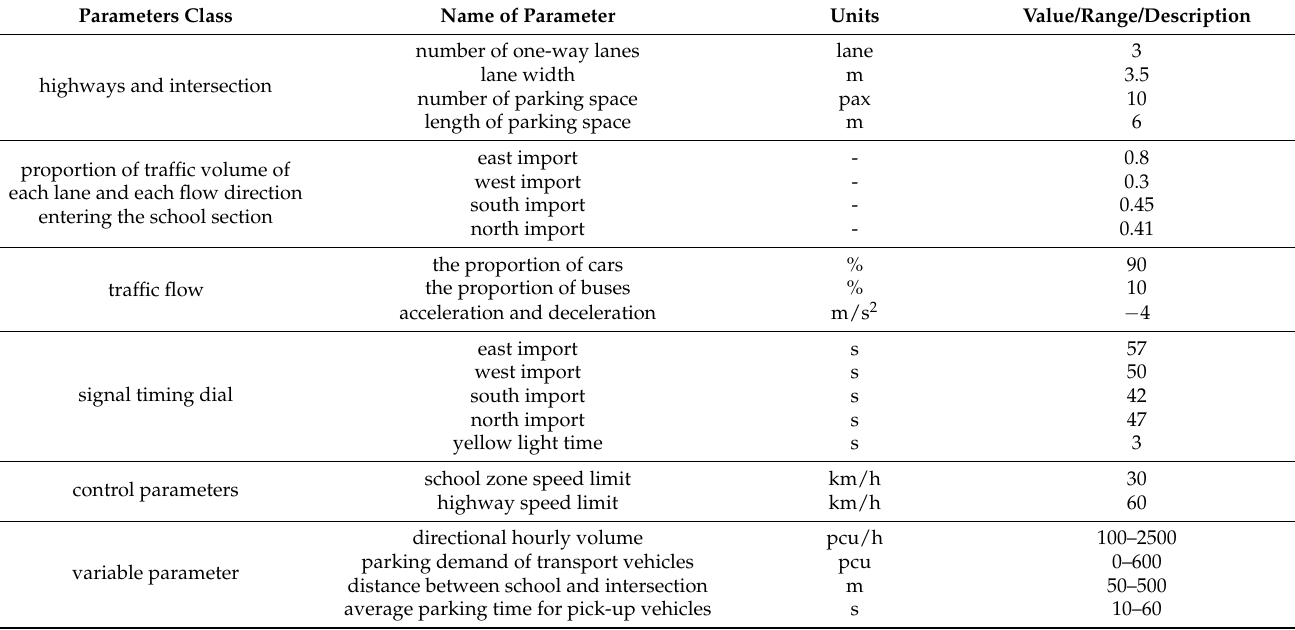
Table 2. Parameter setting of simulation platform.